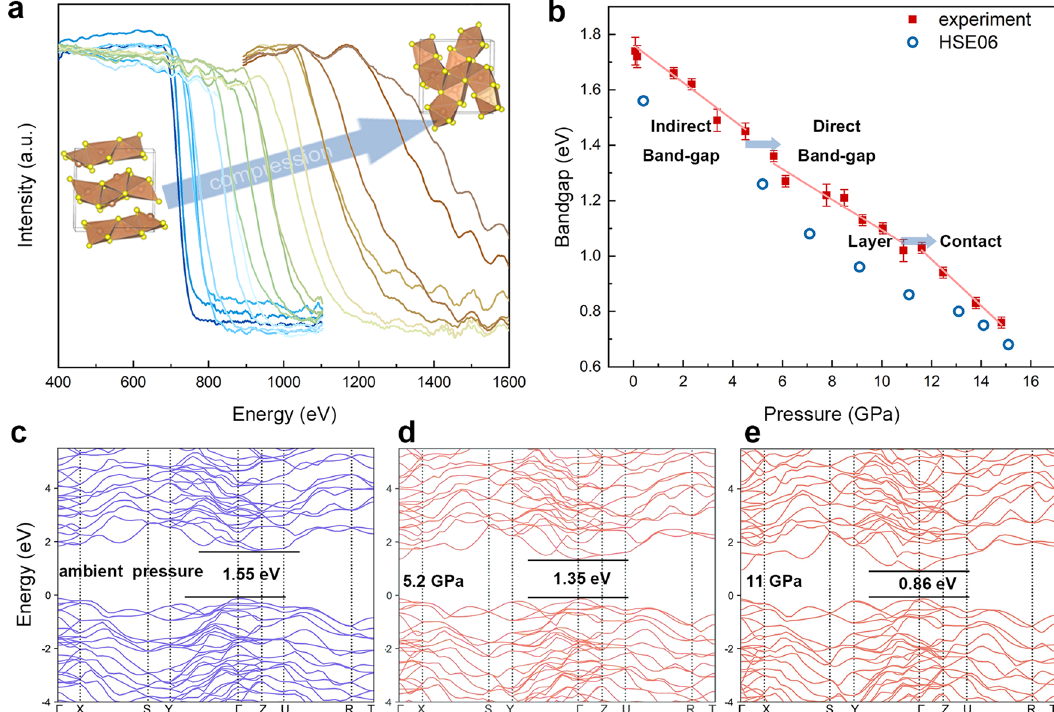
Fig. 3 UV-vis absorbance data to 14.8 GPa. a Results of absorbance from room pressure to 14.8 GPa. b Bandgap fi tting by K-M equation (red) and calculated by DFT with HSE06 (blue). c Electronic structure of Sb 2 S 3 with bandgap 1.55 eV at ambient pressure. d At 5.2 GPa, Sb 2 S 3 is converted into a direct bandgap semiconductor with bandgap 1.35 eV. e Sb 2 S 3 undergoes a 2D-3D phase transition, and the bandgap is compressed to 0.86 eV at 11